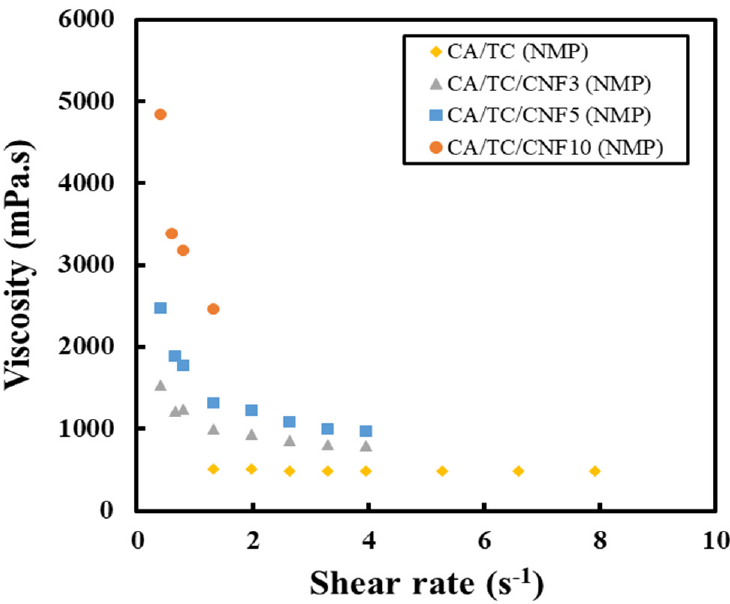
Figure 7. Viscosity of CA/TC and CA/TC/CNF with different CNF content in NMP solvent (Plasti- cizer content 30%).